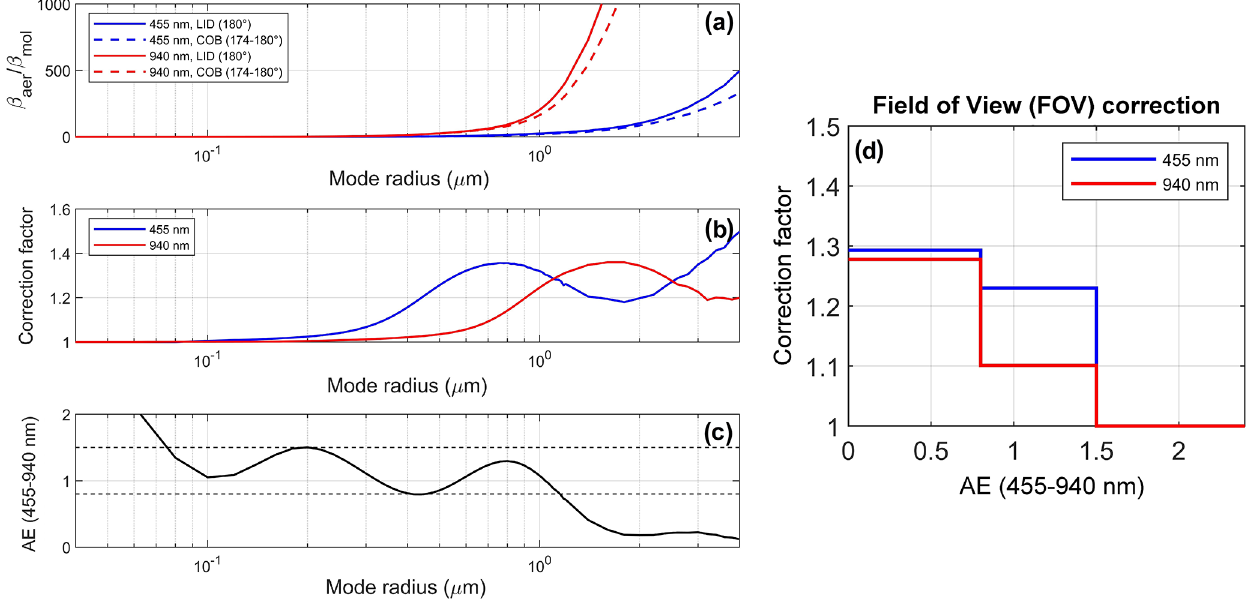
Figure 2. Mie-theory scattering model simulations. Panel (a) : ratio of aerosol-to-molecular-backscatter coefficient, β aer /β mol (i.e., BSR − 1) at 455nm (blue) and 940nm (red), as a function of mode radius ( R m ), calculated assuming a FOV angle of 174–180 ◦ (dashed lines: COBALD) and 180 ◦ (solid lines: lidar), and aerosol number concentration N = 10 3 cm − 3 . Panel (b) : correction factors, i.e., lidar-to- COBALD ratio of β aer /β mol (as shown in panel a ) for 455nm (blue) and 940nm (red), as a function of R m . Panel (c) : simulated Ångström exponent (AE) for the COBALD wavelength interval (455–940nm), as a function of R m . Dashed black lines indicate the thresholds of AE = 0.8 and AE = 1.5 used for the parameterization of the correction factors (see Sect. 3.2). Panel (d) : resulting FOV correction as a function of